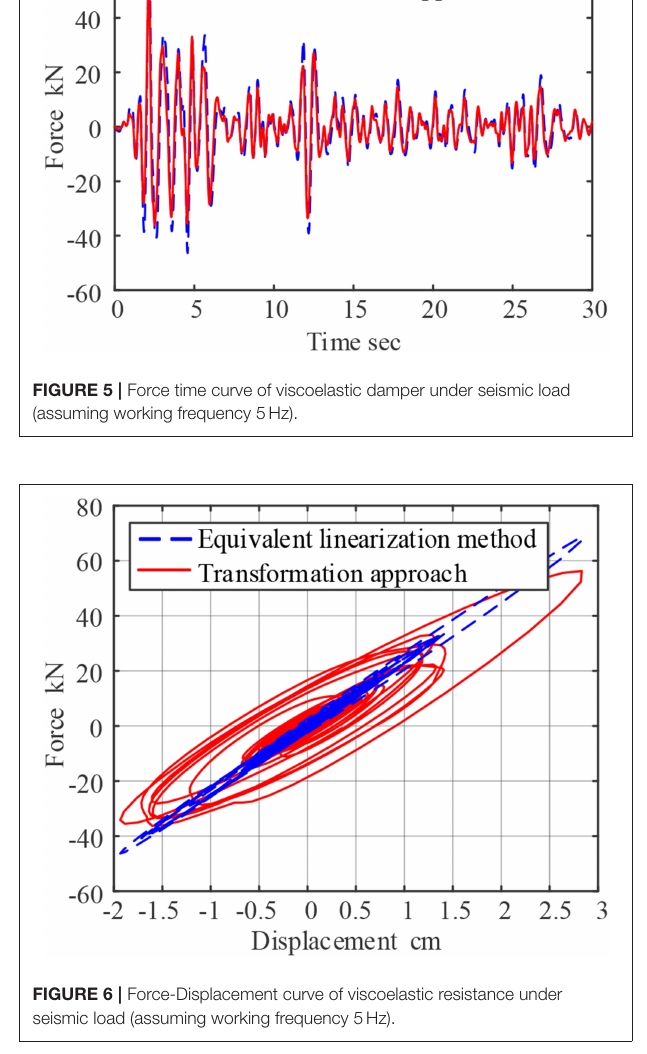
factor η = 0.1905, The force-time curve and force-displacement curve of the viscoelastic system are shown in the blue dashed lines of Figures 5 , 6 .